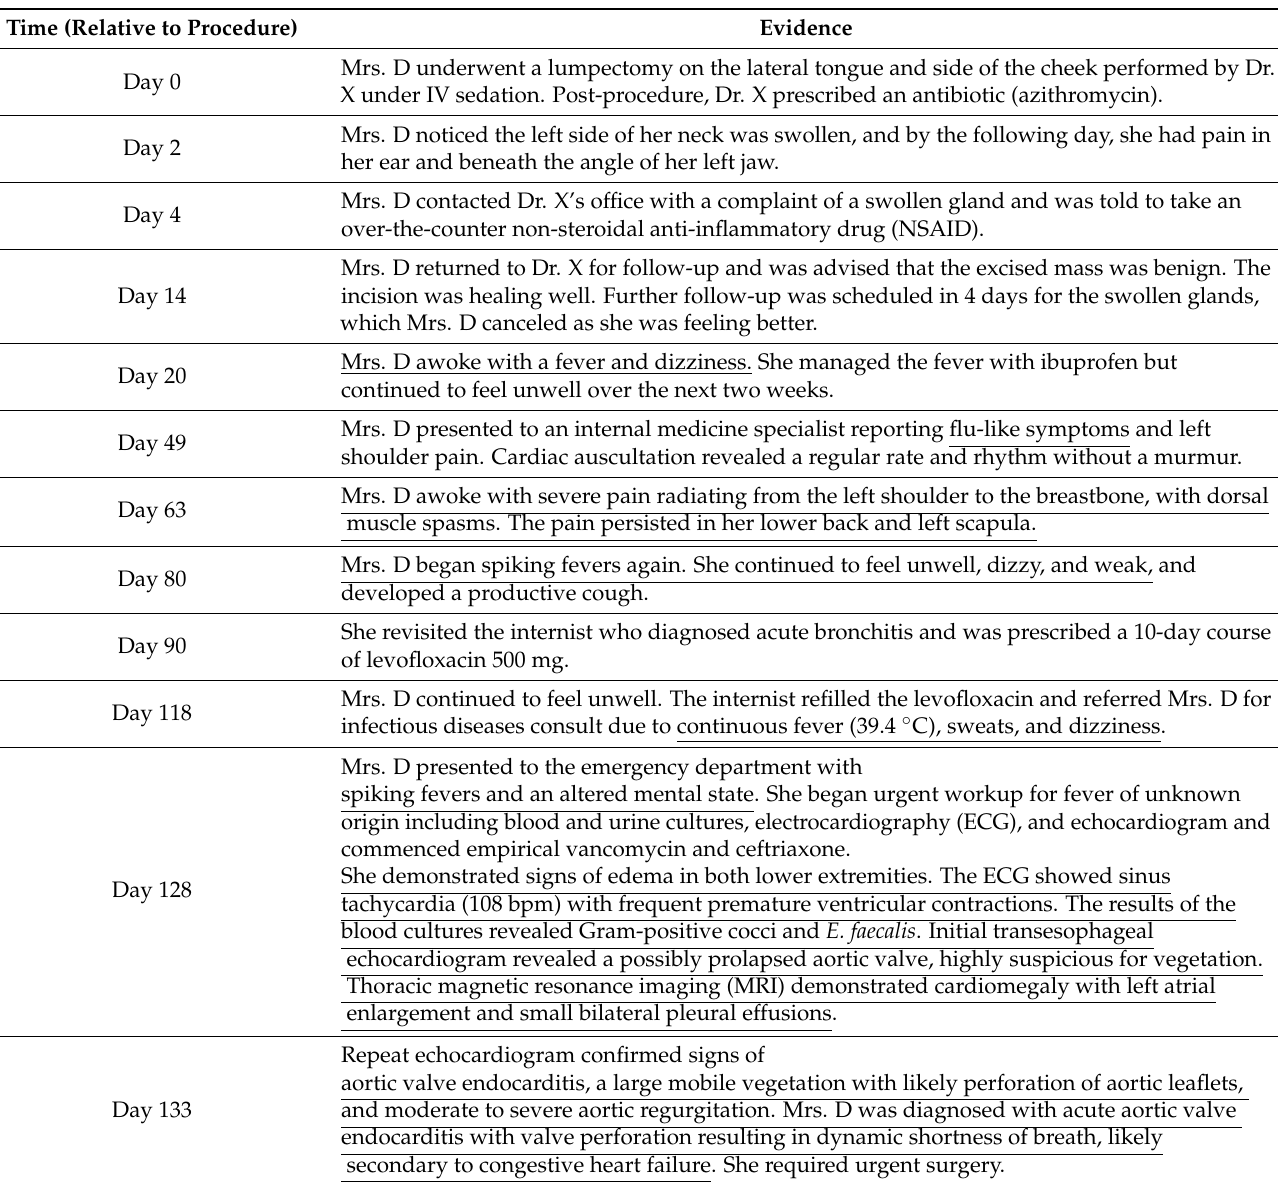
Table 1. Relevant medical history timeline for Mrs. D. Signs and symptoms associated with bacterial endocarditis (BE) are underlined.